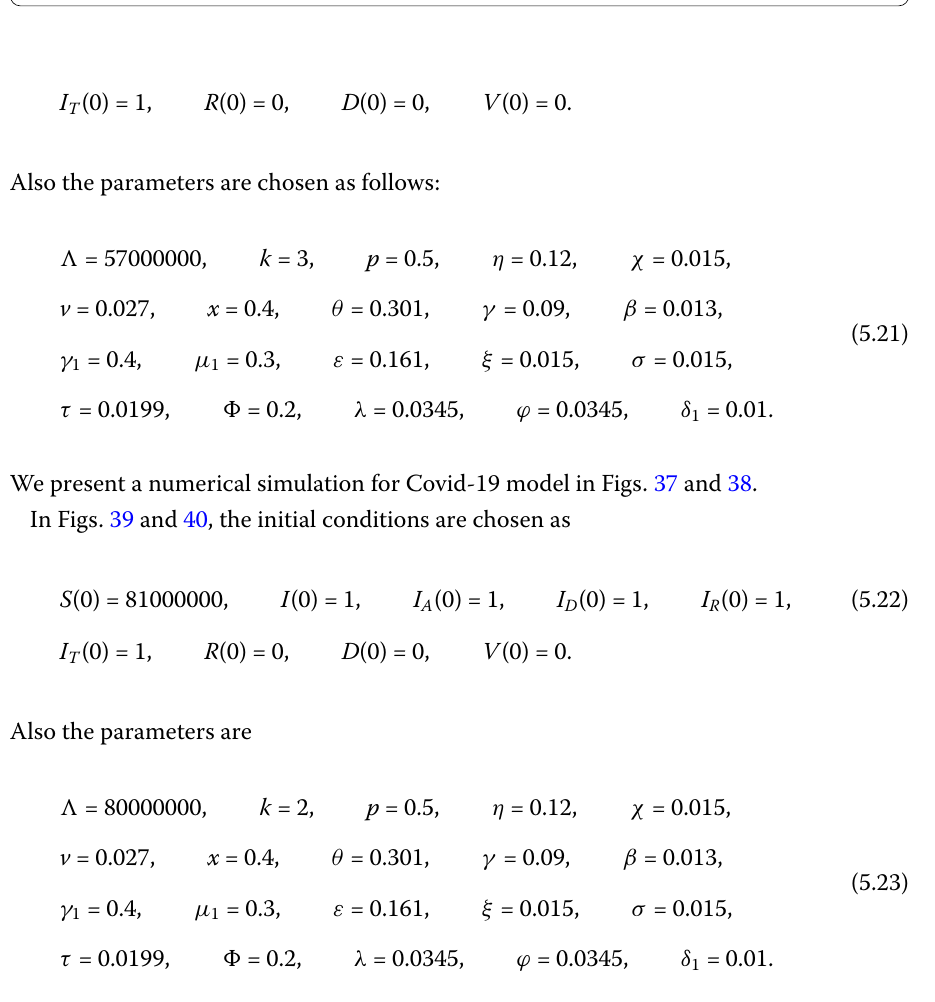
Figure 37 Numerical visualization for Covid-19 model in South Africa for α =